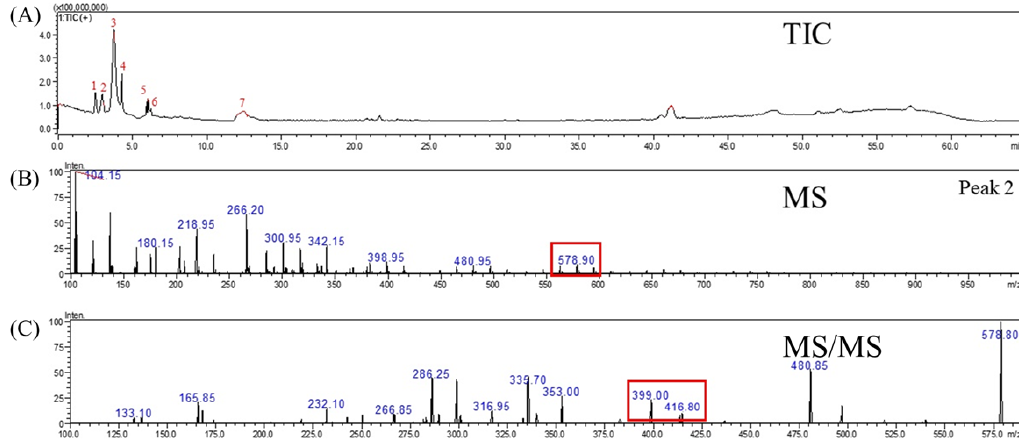
Figure 3. The mass spectrometry of ( A ) total ion chromatogram (TIC), ( B ) MS spectra, and ( C ) MS/MS spectra of the molecule under positive ion mode at m/z 578.90 from the thermally treated radish at 70 °C for 12 days.